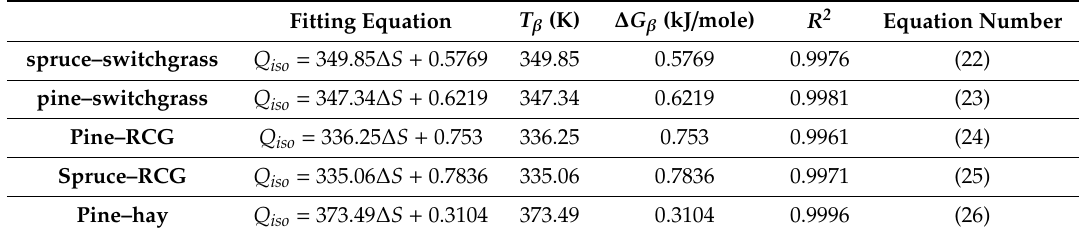
Table 6. Estimation of isokinetic temperature and free energy of